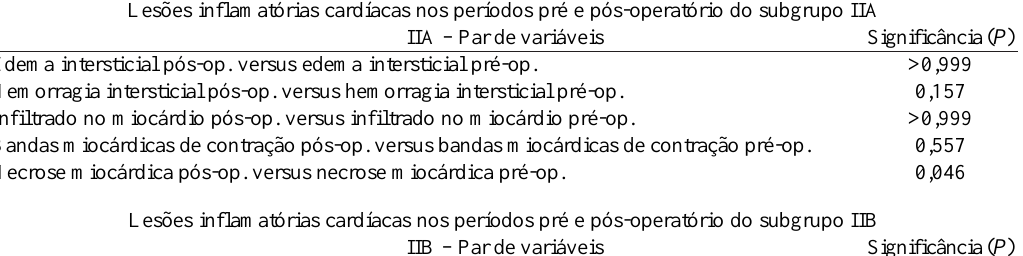
Tabela 5. Lesões inflamatórias cardíacas no grupo II